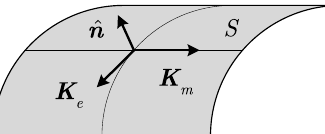
Fig. 1. Electric and magnetic currents on curved surface S.